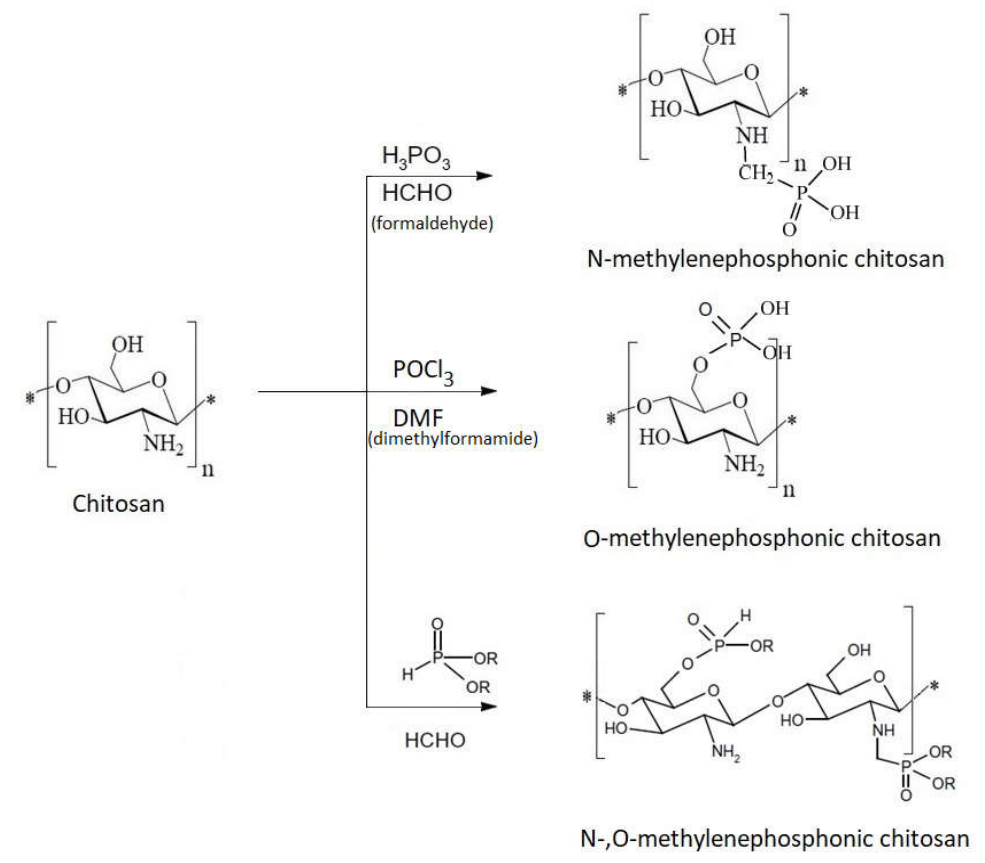
Figure 18. Schematic phosphorylated chitosan derivatives.